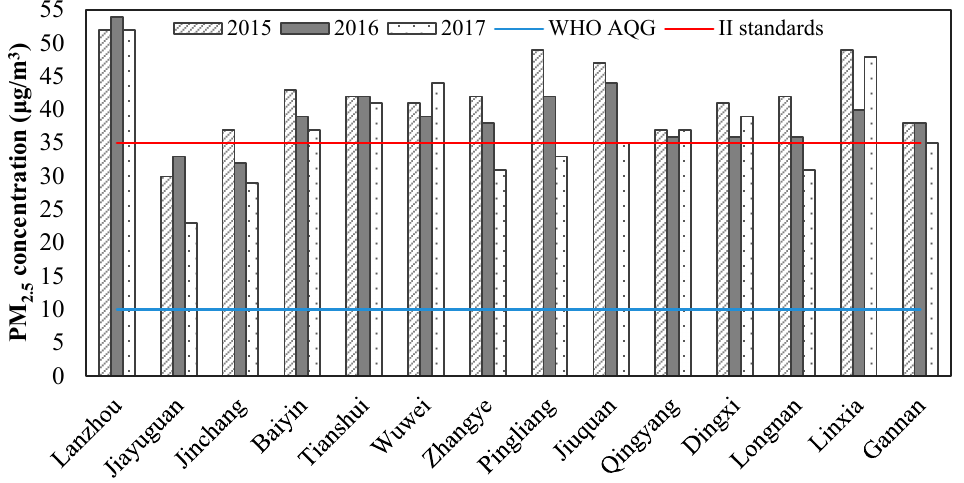
Figure 2. The annual average PM 2.5 concentration of cities in Gansu from 2015 to 2017.